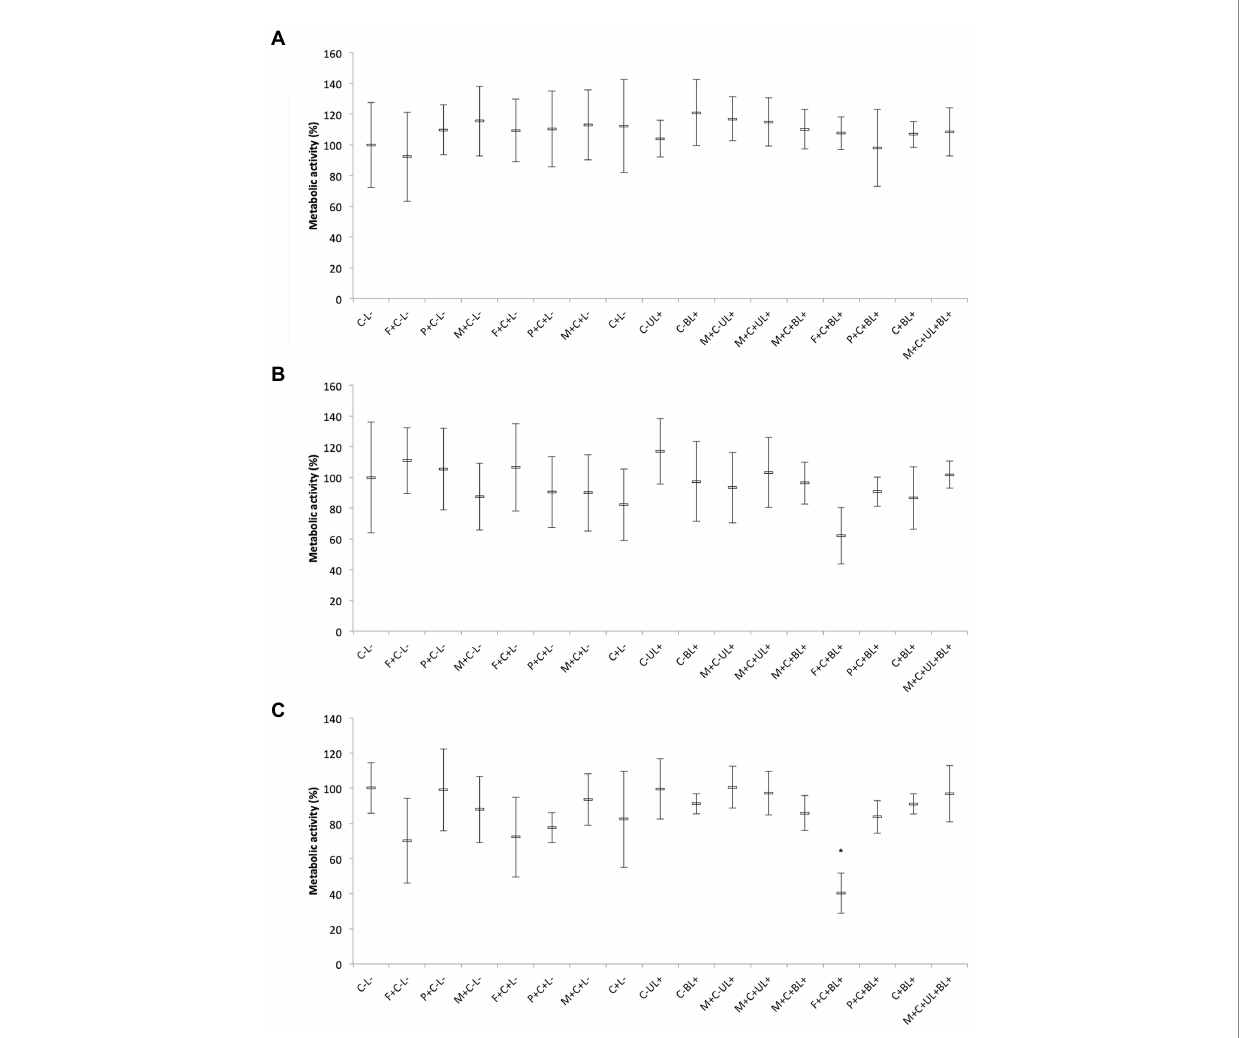
FIGURE 8 Mean values of metabolic activity (%) of MRSA (A) , P. aeruginosa (B) , and C. albicans (C) biofilms obtained in each group of study. Error bars: standard deviation ( n = 12). Asterisks (*) denote significant differences ( p < 0.05) compared with the control (C-L-). The data was analyzed by ANOVA/Welch and Games-Howell post-hoc tests. Groups are described in the Supplementary Chart S1 of Supplementary